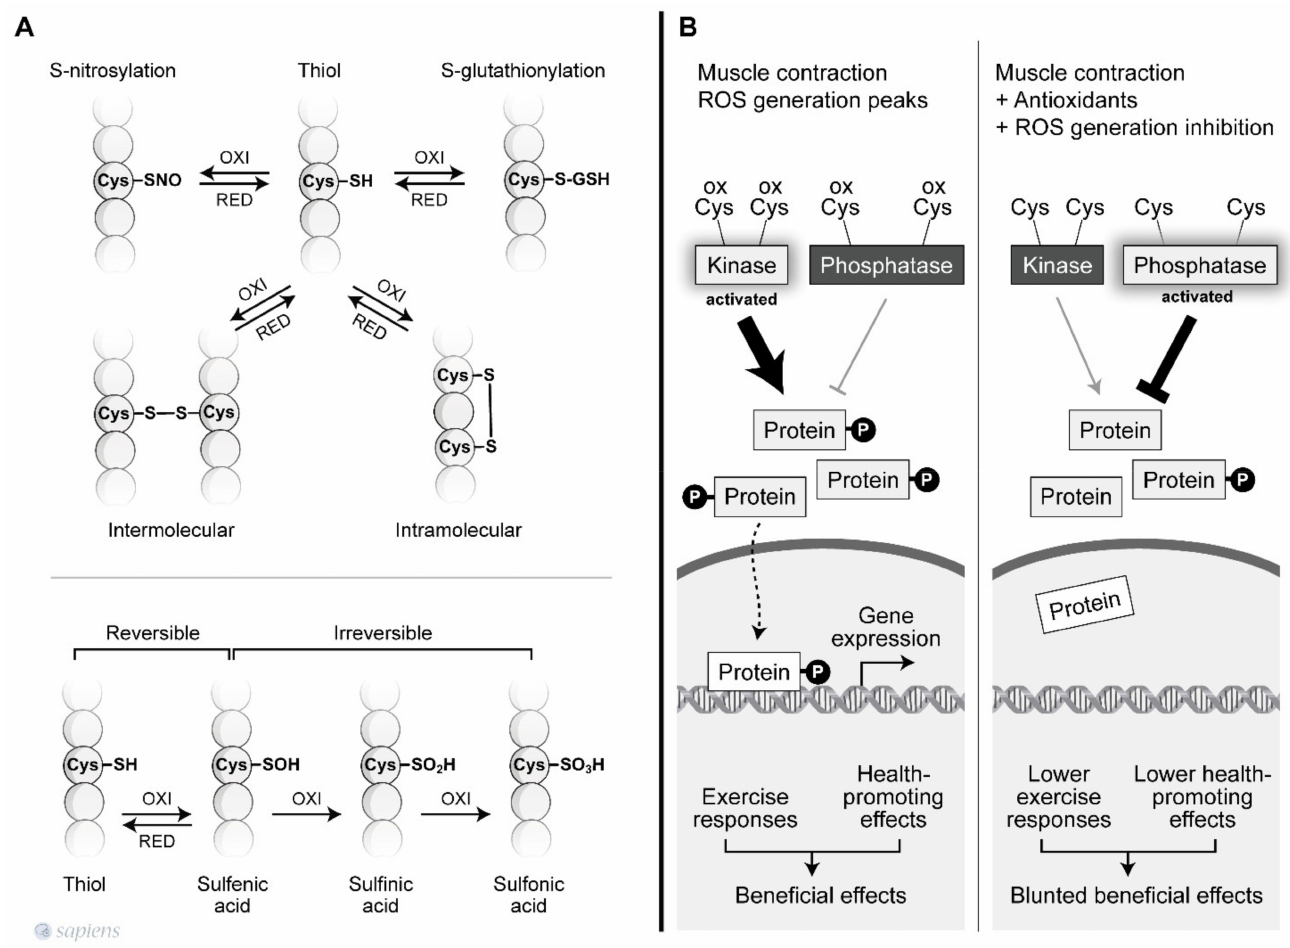
Figure 2. Redox-sensitive cysteine residues. ( A ) Thiol groups are vulnerable to oxidation and can lead to various post- translational modifications that are reversible or irreversible depending on the oxidation degree. Among then, the S- nitrosylation and S-gluthionylation alter the function of several proteins. The sulfhydryl (–SH) group may initially be reversibly oxidized to sulfenic acid (SOH), which is further oxidized to a sulfinic acid (SO 2 H) or irreversibly oxidized to sulfonic acid (SO 3 H). In addition, sulfhydryl groups on cysteines are the preferred targets for oxidation or formation of intra and intermolecular disulfide bonds. ( B ) ROS-mediated signaling orchestrates the final cellular response through the modulation of phosphatases and kinase tone. During muscle contraction, peaks of ROS decrease phosphatase activity and increase kinase activity, activating signaling pathways related to the beneficial effects of exercise. However, factors that disrupt ROS signaling during exercise can alter the kinase/phosphatase tonus leading to a blunted exercise